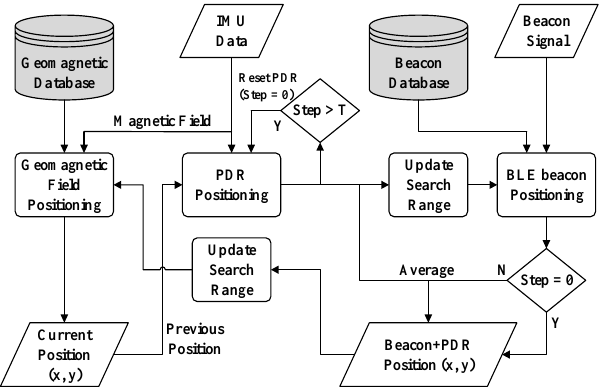
Figure 9. Flow chart of hybrid positioning algorithm (App. 2) using BLE beacon, magnetic field, and